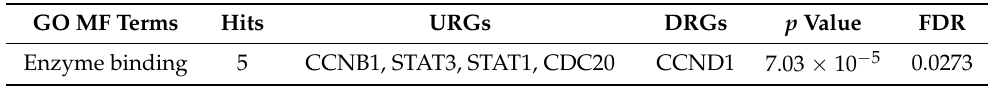
Table 2. Annotation of hub genes in GO MF.